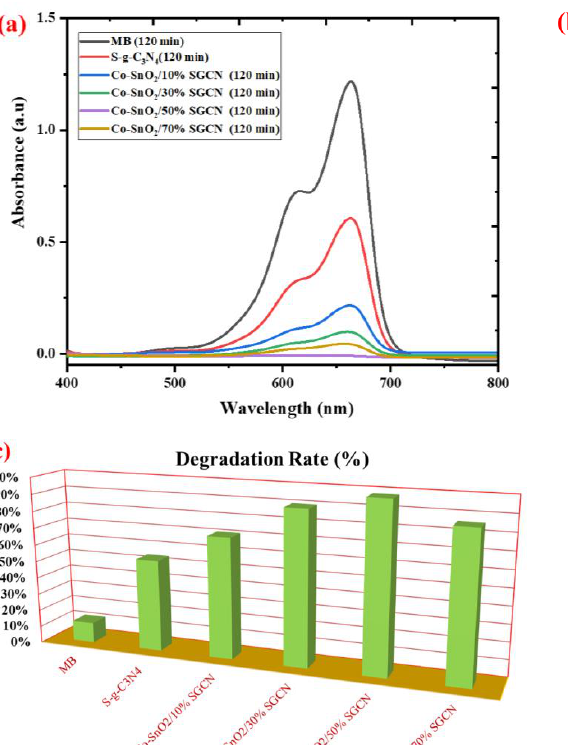
Figure 6. Degradation contours ( a ) Degradation rate ( b ) % Degradation of MB ( c ) by SnO 2 and Co-SnO 2 NPs.